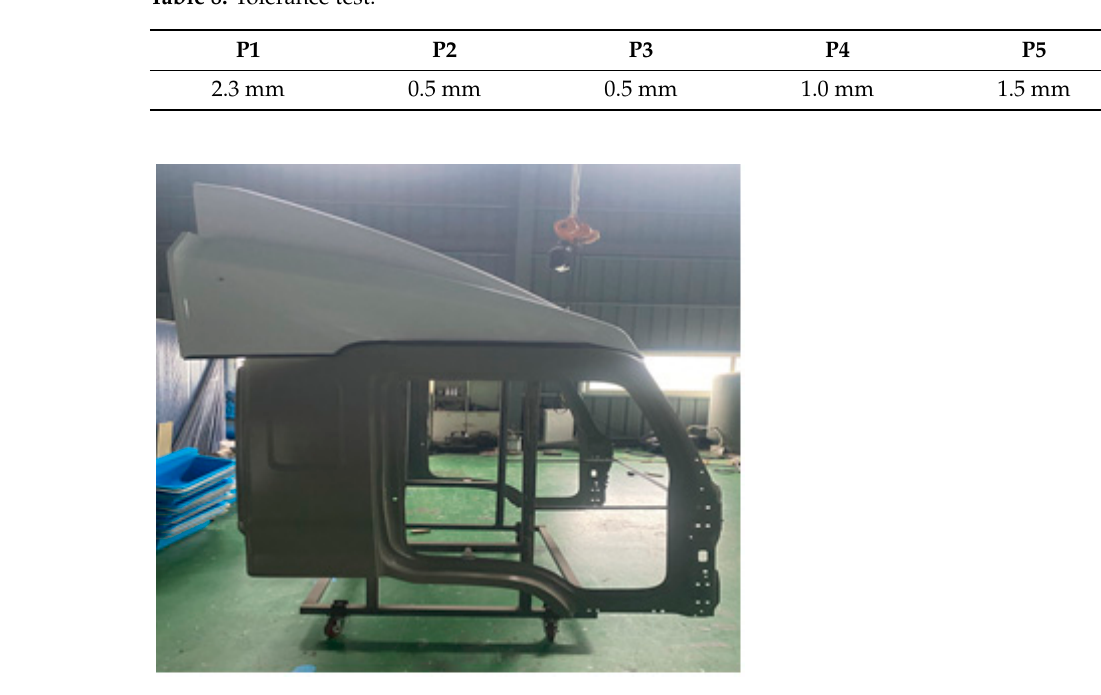
Figure 16. The process of tolerance test.